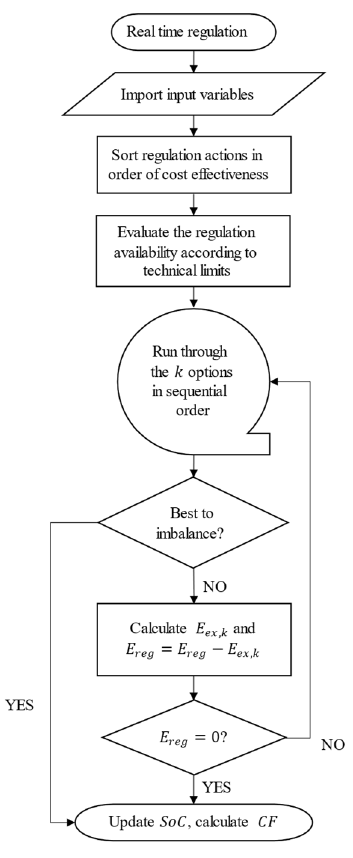
Figure 3. Real-time regulation—Greedy-Indexing Heuristic.